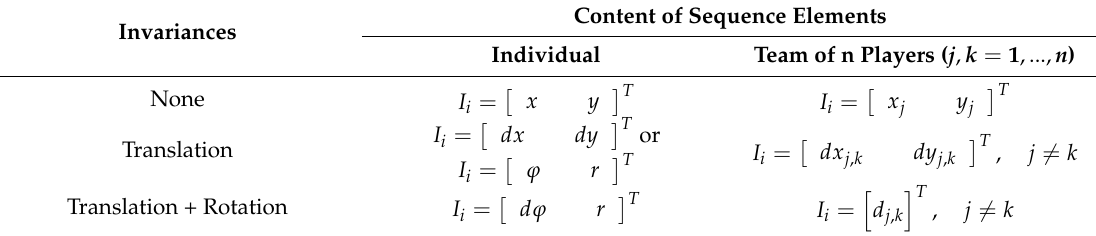
Table 1. Different requirements for the invariances of the patterns lead to different contents of the sequence elements (x, y: coordinates; Φ : heading; r: length of movement vector). Content of Sequence Elements Invariances